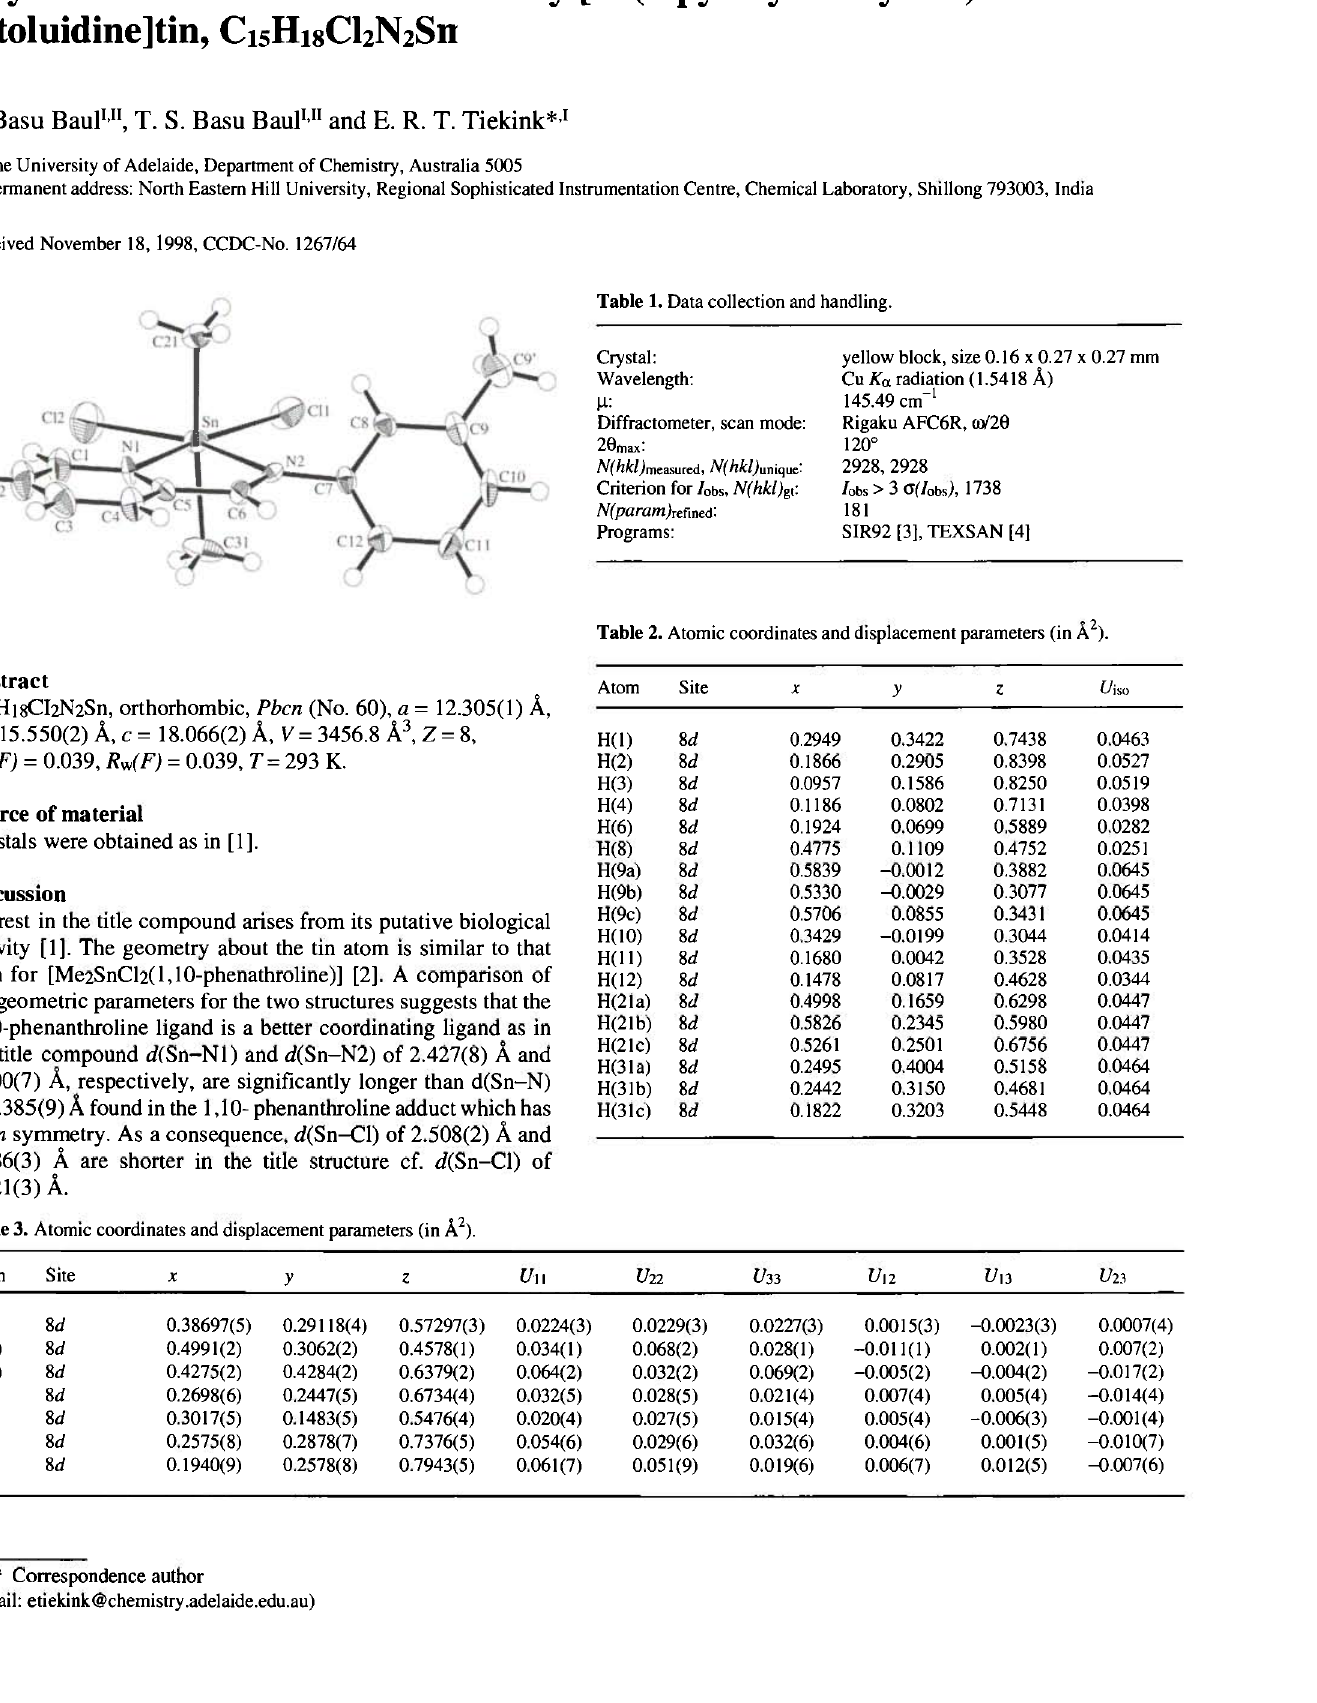
Table 1. Data collection and handling.